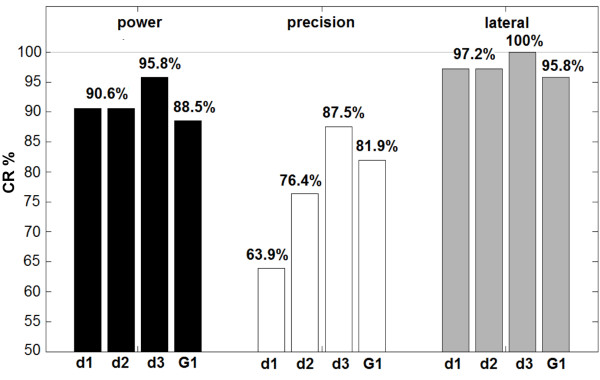
Results: average task-completion rates. Task-completion rates for group G2 on day 1–3 (d1–d3) and for group G1, considering both sets for each object. Black bars represent power grasps, white bars refer to precision grasps and light gray ones to lateral grasps.